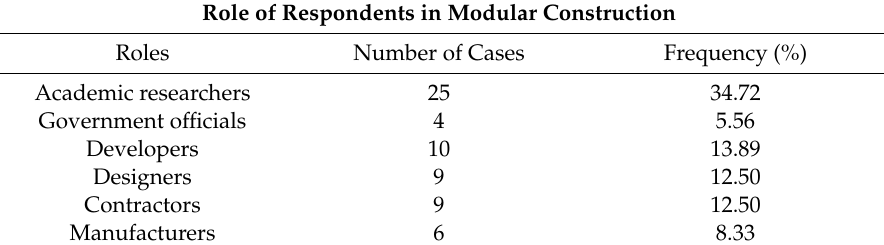
Table 4. Information of